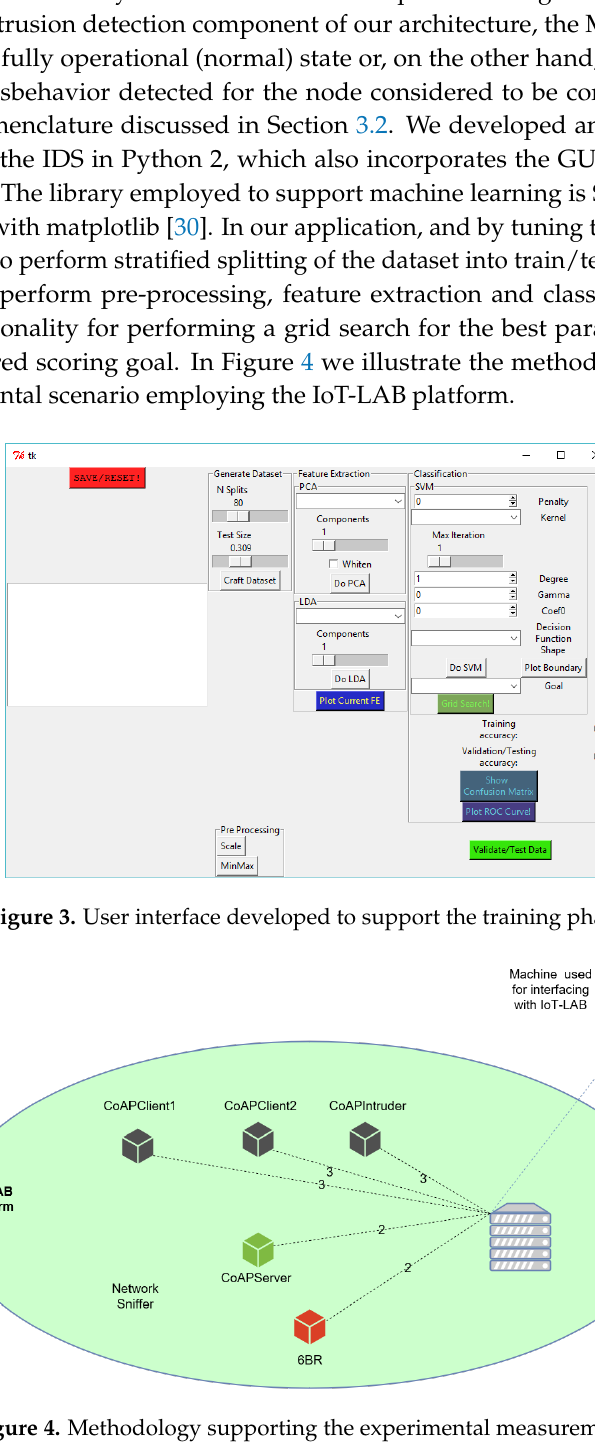
Figure 4. Methodology supporting the experimental